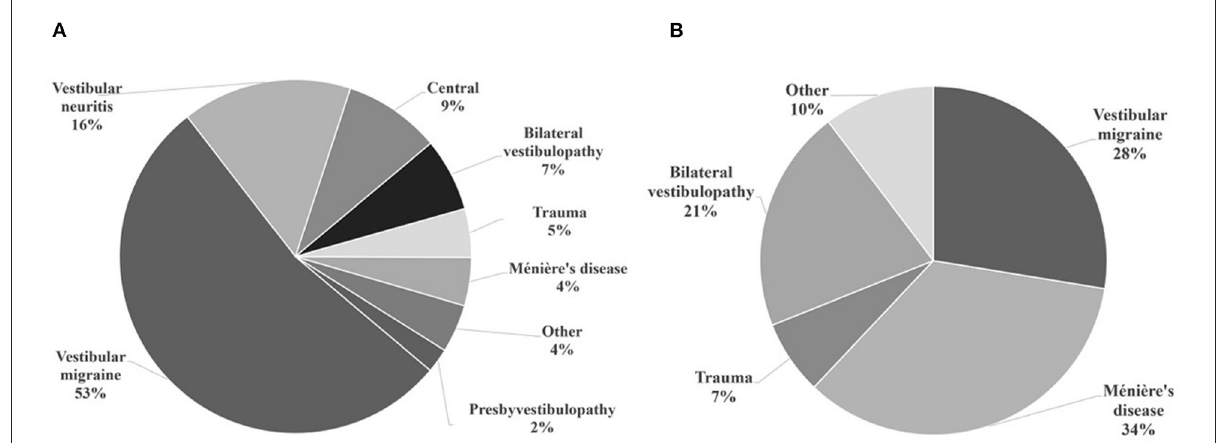
FIGURE2 Otoneurological diagnoses of the included participants. (A) Normal caloric test and abnormal vHIT results. Common diagnoses in this category were vestibular migraine and vestibular neuritis (acute unilateral vestibulopathy). (B) Caloric paresis with dissociated vHIT findings. Common diagnoses in this category were Ménière’s disease and vestibular migraine.